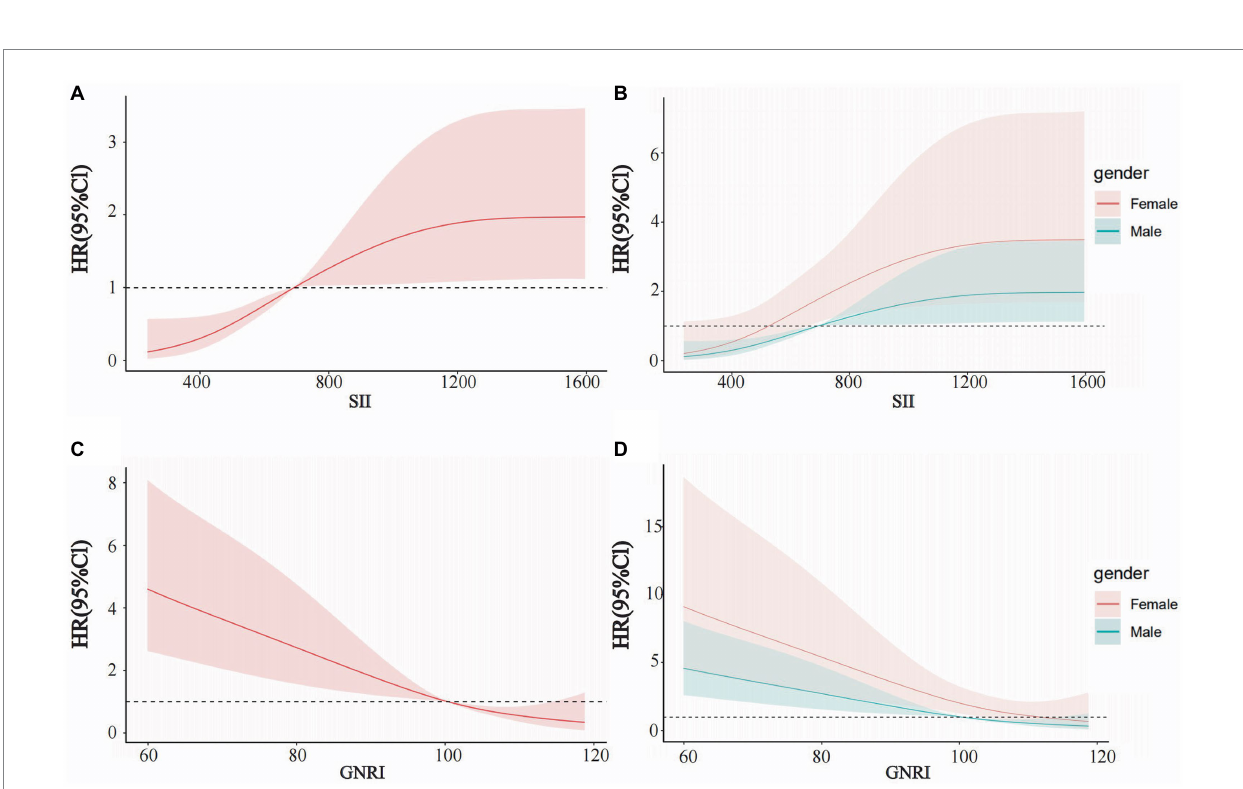
FIGURE 2 Restricted cubic spline curves for SII and GNRI in EOCRC. (A) SII in all patients, (B) SII in males and females, (C) GNRI in all patients, and (D) GNRI in males and females.